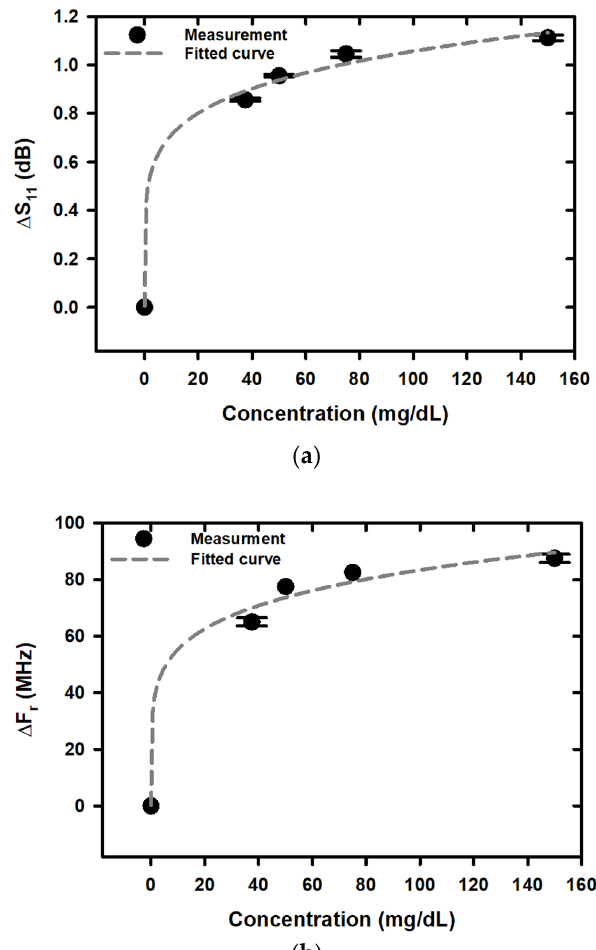
Figure 8. Plot of glucose concentration versus ( a ) ∆ S 11 and ( b ) ∆ F r with R 2 = 0.9955.